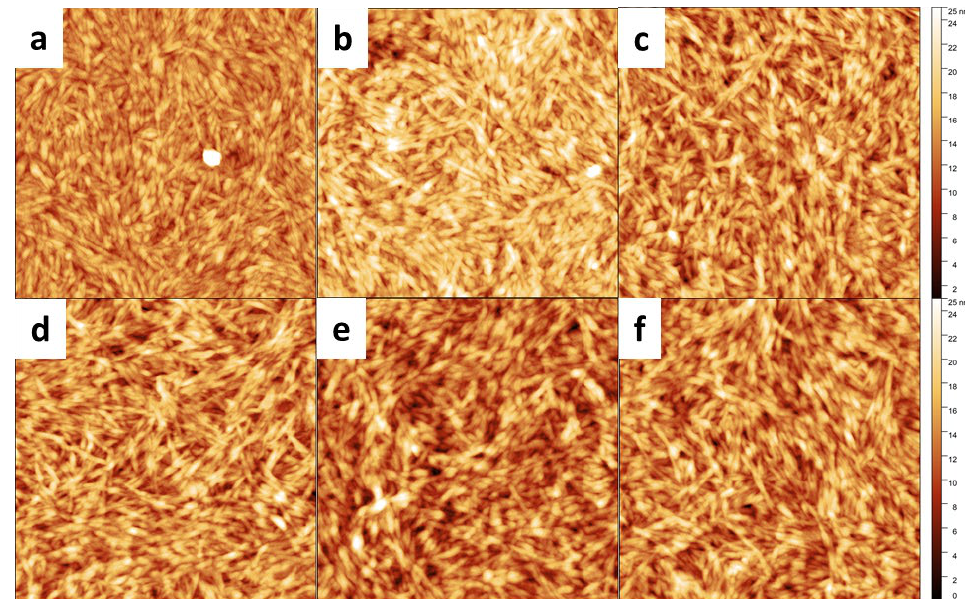
Figure 3. Atomic force microscopy topography imaging (2 × 2 μm 2 ) of casted films using suspensions of ( a ) H-CNC, ( b ) Li-CNC, ( c ) Na-CNC, ( d ) K-CNC, ( e ) Rb-CNC, and ( f ) Cs-CNC.